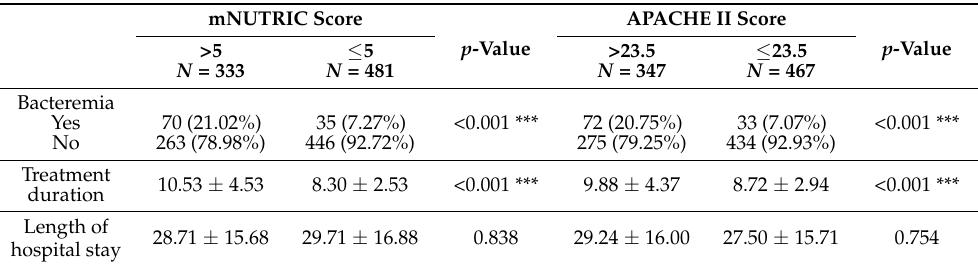
Table 7. Relevance between bacteremia, treatment duration, length of hospital stay, mNUTRIC score, and APACHE II